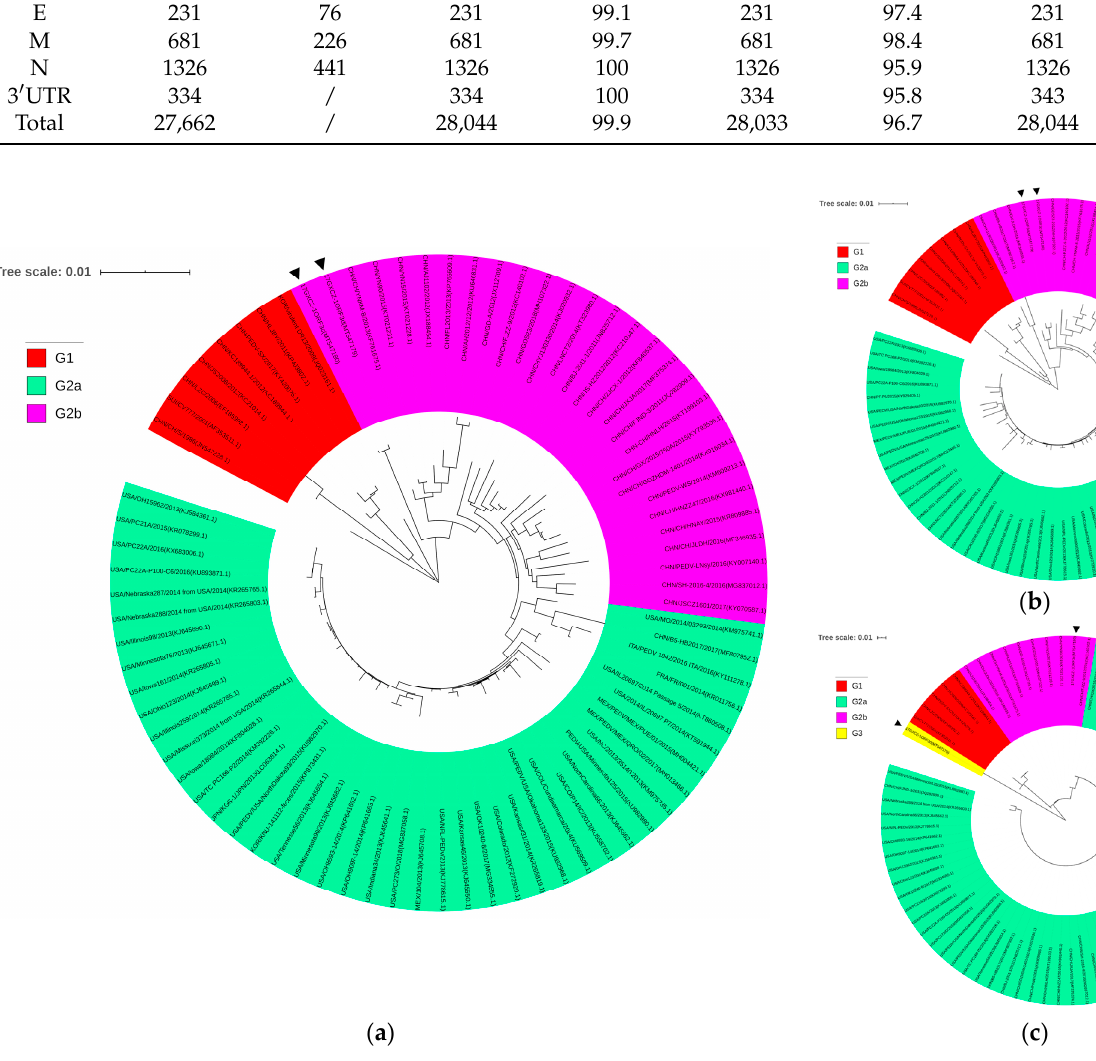
Figure 3. Genotyping and origin of the PEDV strains 17GXCZ-1ORF3d and 17GXCZ-1ORF3c based on different genes. Phylogenetic trees were constructed based on the aligned full-length genomes ( a ) S protein and ( b ) ORF3 protein ( c ) by using the neighbor-joining method from MEGA 5.2, with 1000 bootstrap replicates. Scale bars represent the branch lengths measured by the number of substitutions per site. Each PEDV strain is indicated in the following format: country of origin (three letter code: CHN, China; JPN, Japan; KOR, Korea; MEX, Mexico; SUI, Switzerland; and USA, the United States)/strain name/year of sample collection (Genbank accession number). Group 1, G2a subgroup, G2b subgroup and Group 3 are coded in red, green, pink and yellow, respectively. The triangle symbols represent the strains obtained in this study.